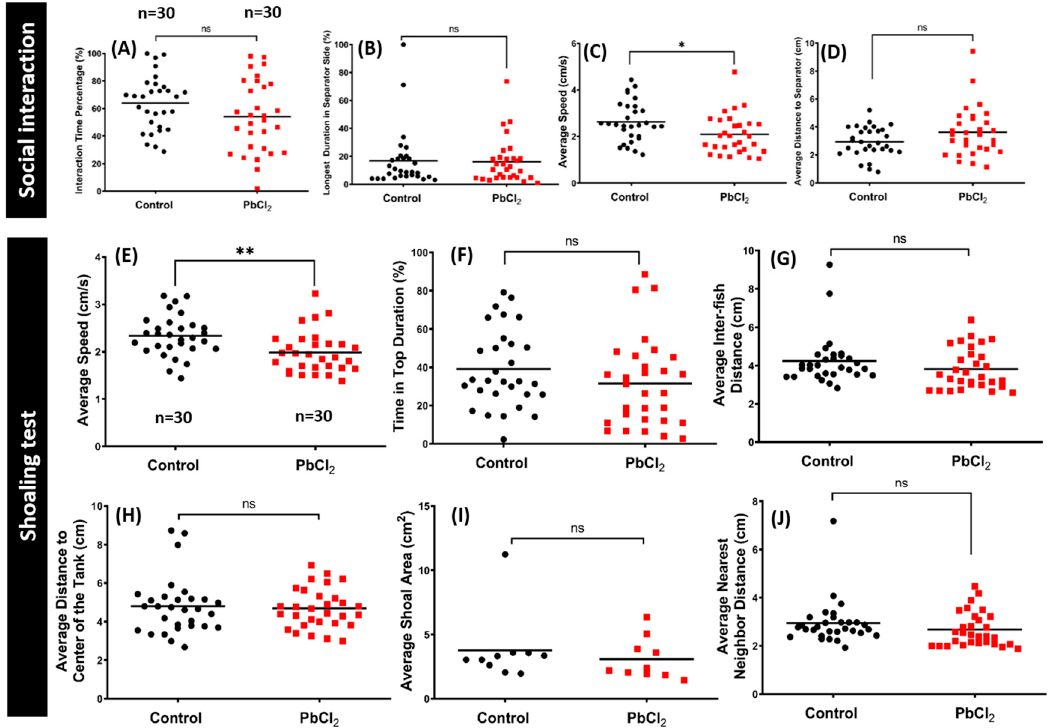
Figure 5. Comparison of the conspecific social interaction and shoaling between control and 50 ppb PbCl 2 -treated fish. After PbCl 2 exposure, the conspecific social interaction was monitored and the data are presented as ( A ) interaction time percentage, ( B ) longest duration in the separator side, ( C ) average speed, and ( D ) average distance to the separator. The data are expressed as the mean values and analyzed by the Mann–Whitney test ( n = 30; * p ≤ 0.05). For the shoaling test, after PbCl 2 exposure, the shoaling behavior was monitored at 30 days post-treatment and the data are presented as ( E ) average speed, ( F ) time in the top duration, ( G ) average inter-fish distance, ( H ) average distance to the center of the tank, ( I ) average shoal area, and ( J ) average nearest neighbor distance. Data are expressed as the mean values and analyzed by the Mann–Whitney test ( n = 30; ** p ≤